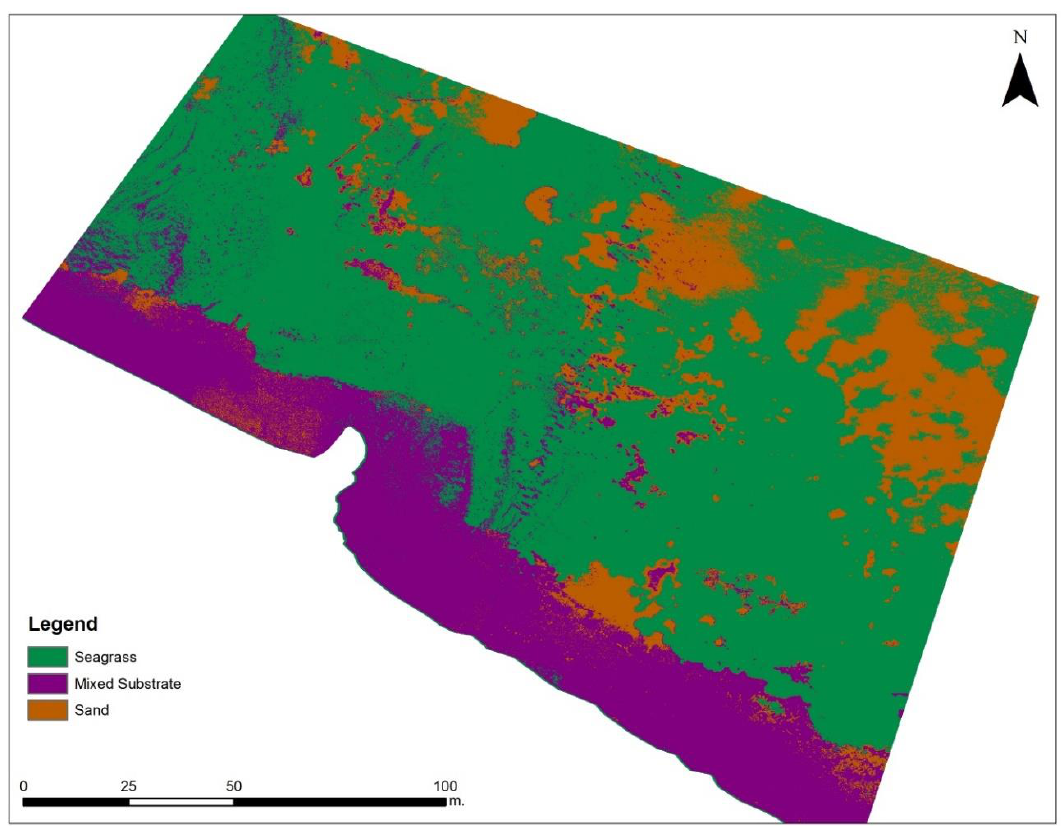
Figure 6. Classified map of the first case study on 17 April 2019 (optimal day).